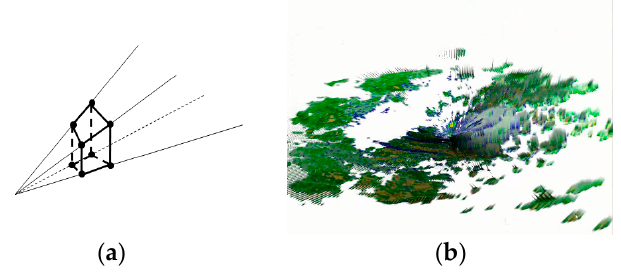
Figure 14. Visualization of raw radar data in irregular structure. ( a ) Logical link mode; ( b ) Visualization of raw radar data.